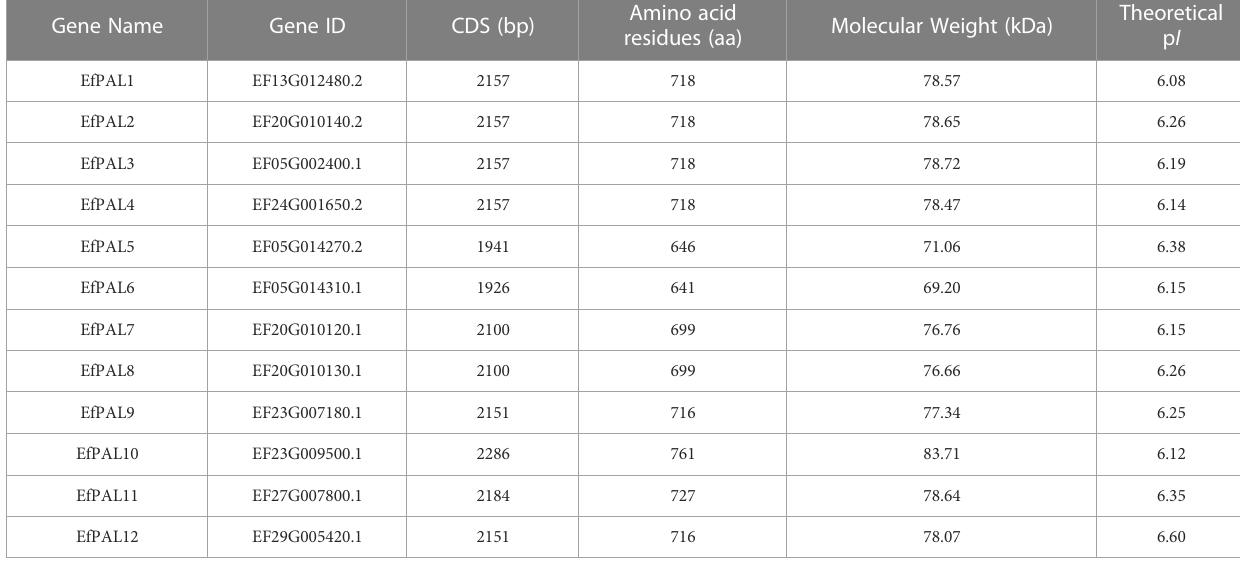
TABLE 2 Statistical analyses of sequence length, molecular weight, isoelectric point in E.